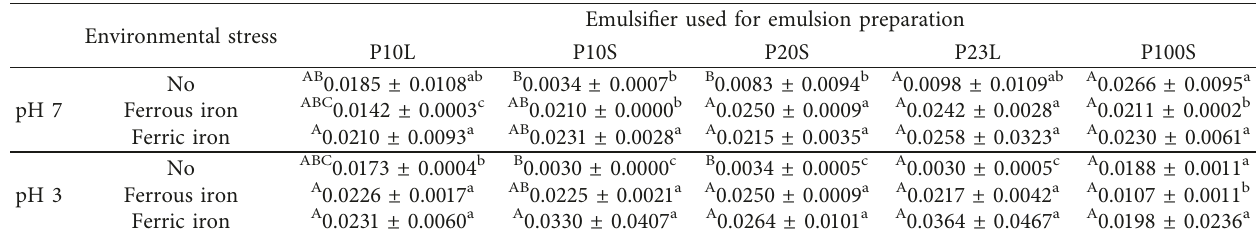
Table 1: The initial decomposition rate (mmol/kg emulsion/day) of α -tocopherol in emulsions stabilized with emulsifiers having various sizes of hydrophilic and hydrophobic groups. Environmental stress